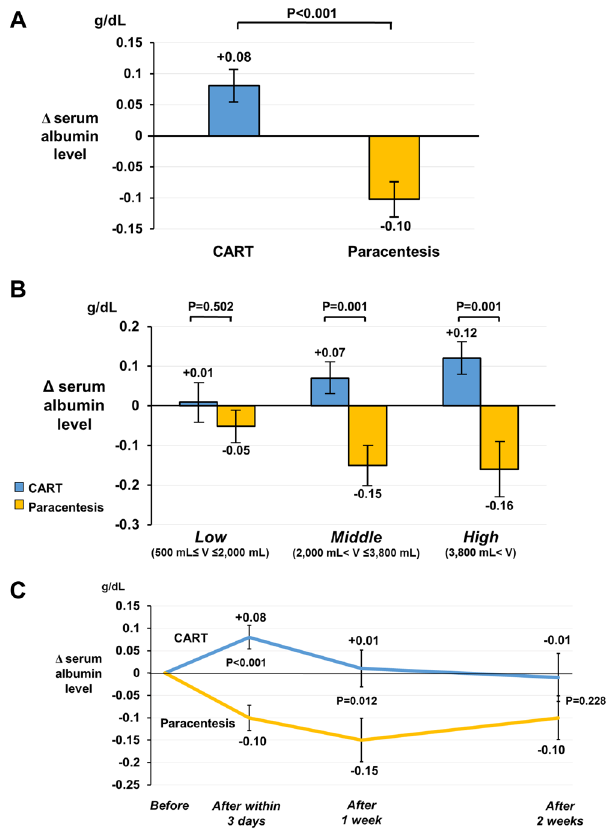
Figure 2. Δ serum albumin level in the CART and paracentesis groups. ( A ) Short-term Δ serum albumin level was compared between the CART group (N = 88) and the paracentesis group (N = 108) by univariate analysis (Student t -test). ( B ) Drained ascites volume was divided into tertiles (low volume layer, 11 CART and 56 paracentesis; middle volume layer, 41 CART and 27 paracentesis; high volume layer, 36 CART and 25 paracentesis) for stratified analysis. Univariate analysis by the Student t -test was employed. ( C ) Long-term Δ serum albumin level following drainage treatment. Comparisons between the groups were performed using the Student t -test. The number of data samples used for the analysis at 1 week after drainage treatment was 73 CART and 90 paracentesis, while that at 2 weeks was 60 CART and 83 paracentesis. Blue bar, CART group; yellow bar, paracentesis group; blue line, CART group; yellow line, paracentesis group. Error bars represent standard error. Abbreviation: V, volume.